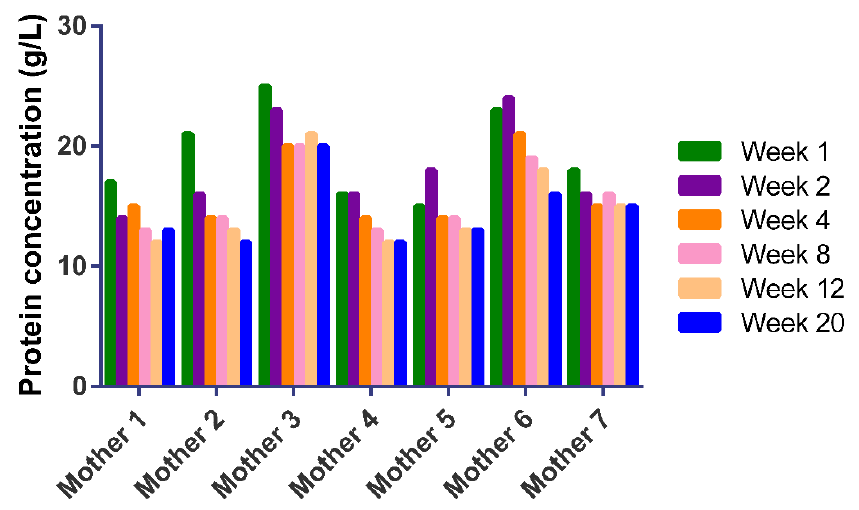
Figure 1. Total bicinchoninic acid (BCA) serum protein concentrations (g/L) in Chinese human milk per mother over a 20-week lactation period.